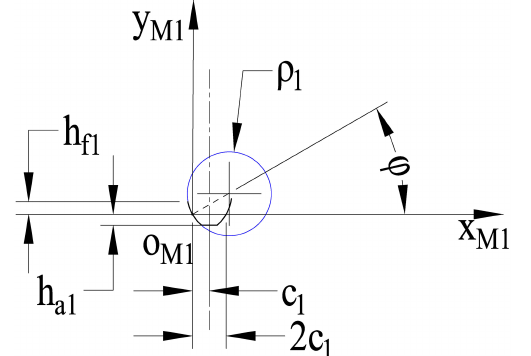
Figure 3. Schematic diagram of the normal tooth profile of the driv- ing line gear.